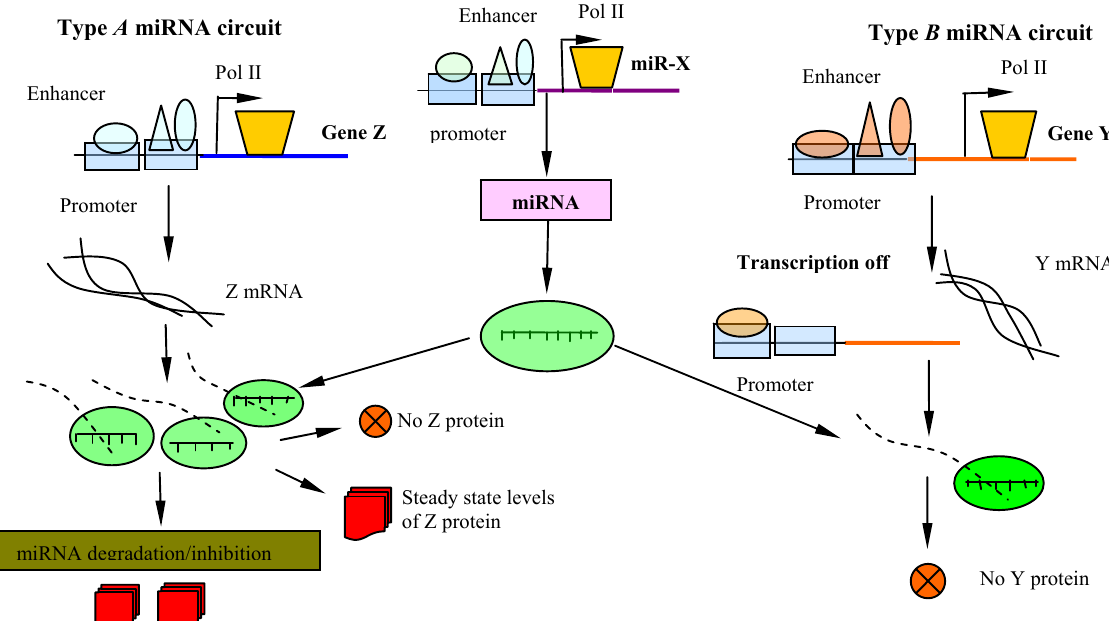
Fig. 1. Integrating miRNAs into regulatory networks. Type A circuits might be involved in maintaining protein steady-state levels and homeostasis. Type B circuits can serve as a surveillance mechanism to suppress leaky transcription of target